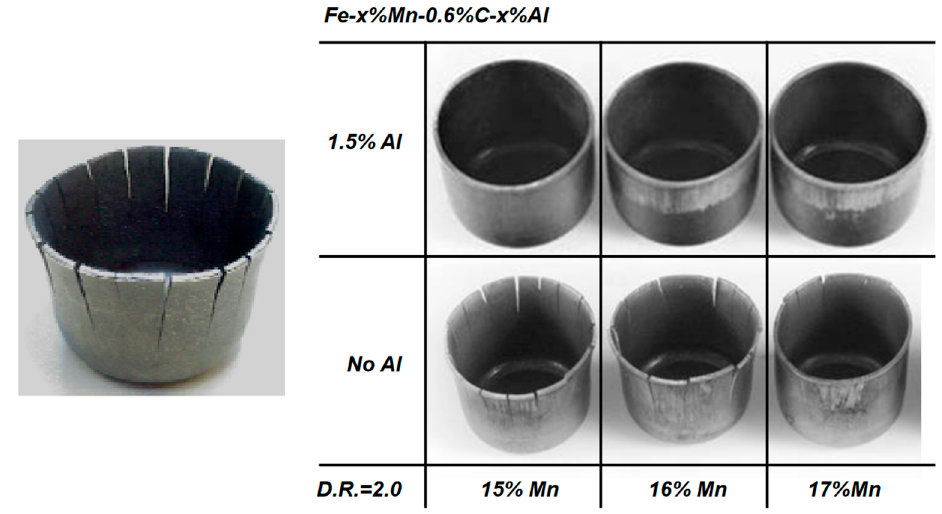
Figure 8. Example of delayed fracture deep drawn Fe-22%Mn-0.6%C TWIP steel (Left). Suppression of delayed fracture in deep drawn Fe-(15-17)%Mn-0.6%C TWIP steel by alloying additions of 1.5% Al (Right) [9,10].